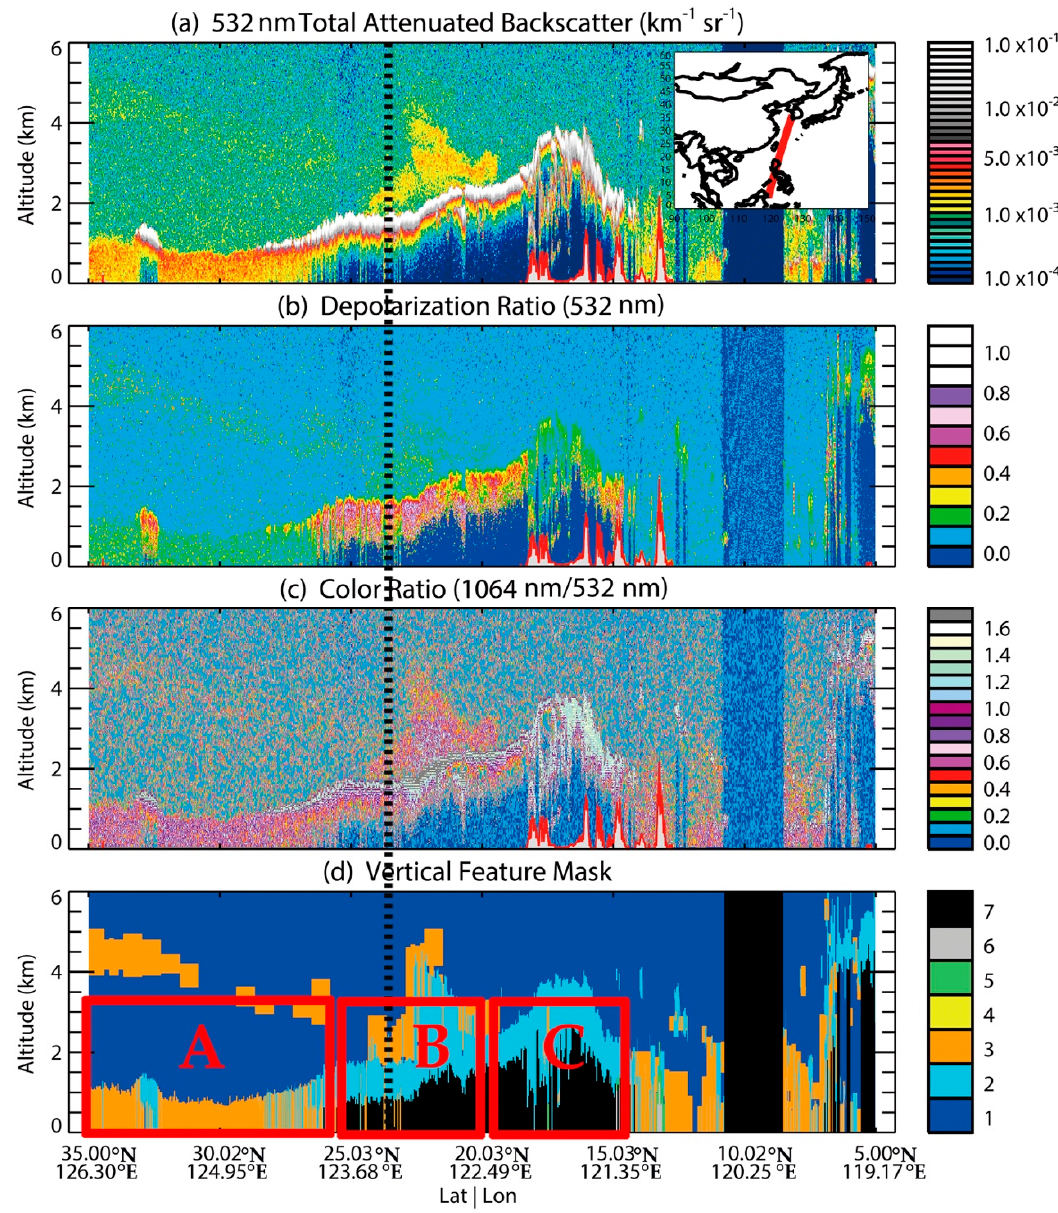
Figure 5. Vertical structure of the dust aerosols and clouds observed by the satellite CALIPSO lidar at 01:33 LST on 15 March 2009. The black dotted line (right panel) indicates the location of CALIPSO that is closest to the ground lidar site.